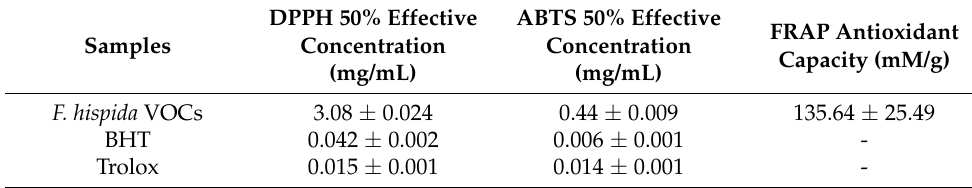
Table 2. Antioxidant activities of F. hispida volatile organic compounds expressed as IC 50 values ( µ g/mL) for DPPH and ABTS, and antioxidant capacity for the FRAP assays. DPPH 50% Effective ABTS 50% Effective Samples Concentration (mg/mL)